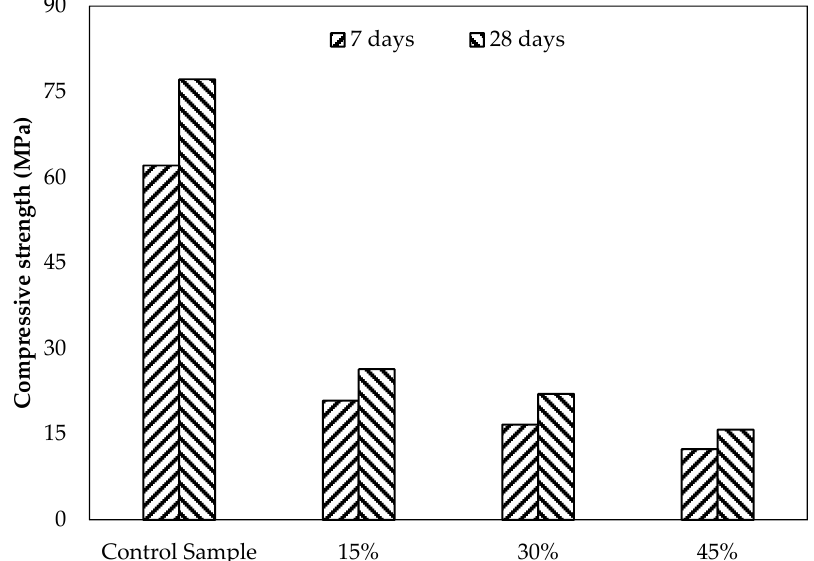
Figure 8. Comparison of compressive strength for the porous sample with the control sample.